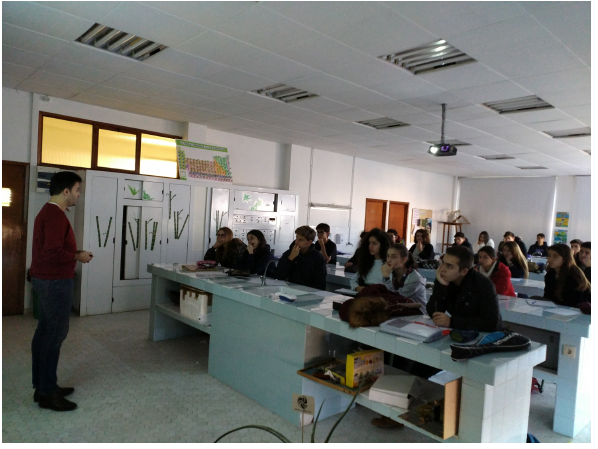
Figure 9. One of the authors presenting the technique to students of Santiago Apostol School in